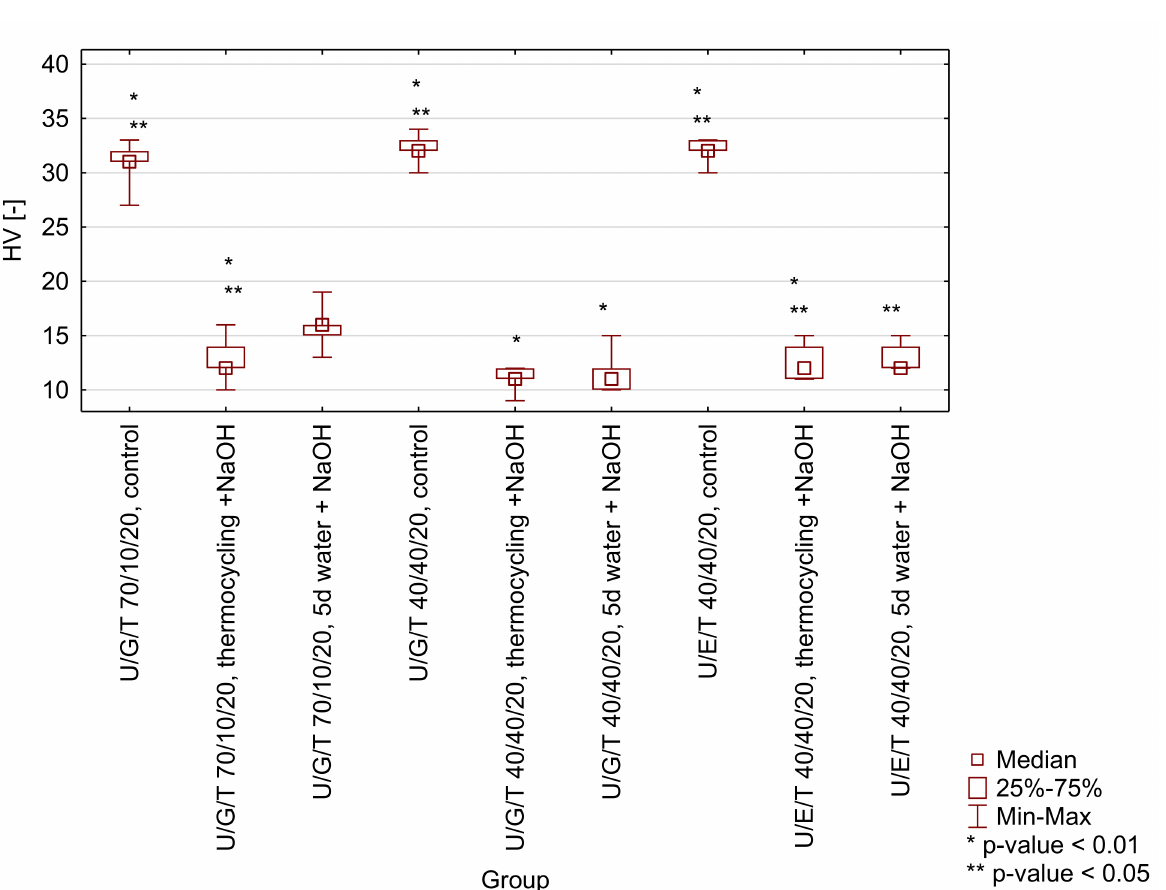
Figure A6. Box-and-whisker plot of Vickers hardness (HV) of tested composites (UDMA/Bis- GMA/TEGDMA 70/10/20 wt.% and 40/40/20 wt.% and UDMA/Bis-EMA/TEGDMA 40/40/20 wt.%) after selected ageing protocols (control-water, 24 h, 37 ◦ C; thermocycling + NaOH- water, 7500 thermo cycles, 5/55 ◦ C and 0.1 M NaOH, 7 days, 60 ◦ C; 5d water + NaOH-water, 5 days, 55 ◦ C and 0.1 M NaOH, 7 days). Statistical differences occur in a given group with a probability of p < 0.01 (*) and/or p < 0.05 (**). Table A5. Probabilities for multiple comparison testing for Vickers hardness (HV) of tested composites. Tested group: 1-UDMA/bis-GMA/TEGDMA 70/10/20, control; 2-UDMA/bis- GMA/TEGDMA 70/10/20, thermocycling +NaOH, 3-UDMA/bis-GMA/TEGDMA 70/10/20, 5d water + NaOH, 4-UDMA/bis-GMA/TEGDMA 40/40/20, control; 5-UDMA/bis-GMA/TEGDMA 40/40/20, thermocycling +NaOH; 6-UDMA/bis-GMA/TEGDMA 40/40/20, 5d water + NaOH; 7-UDMA/bis-EMA/TEGDMA 40/40/20, control; 8-UDMA/bis-EMA/TEGDMA 40/40/20, thermo- cycling +NaOH, 9-UDMA/bis-EMA/TEGDMA 40/40/20, 5d water + NaOH.